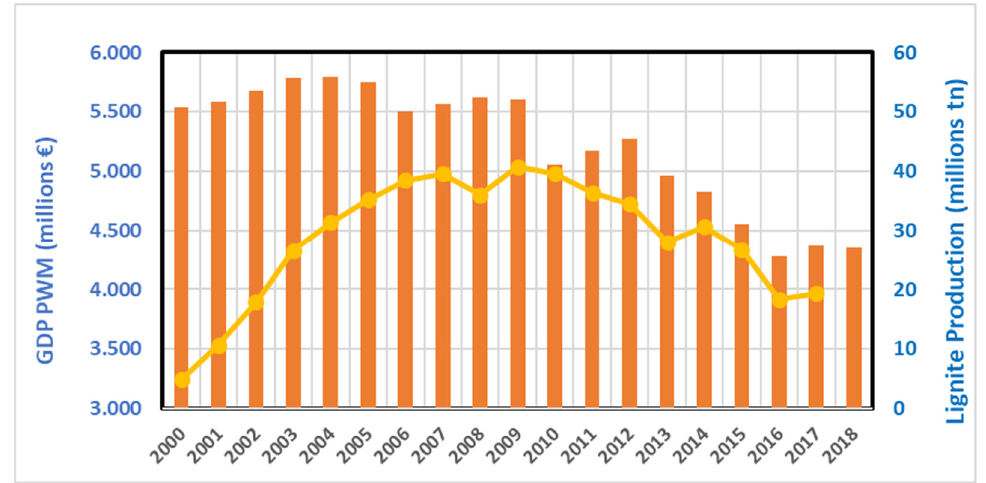
Figure 3. GDP of the region of Western Macedonia in relation to lignite production. Author estimates based on Eurostat and national statistics.